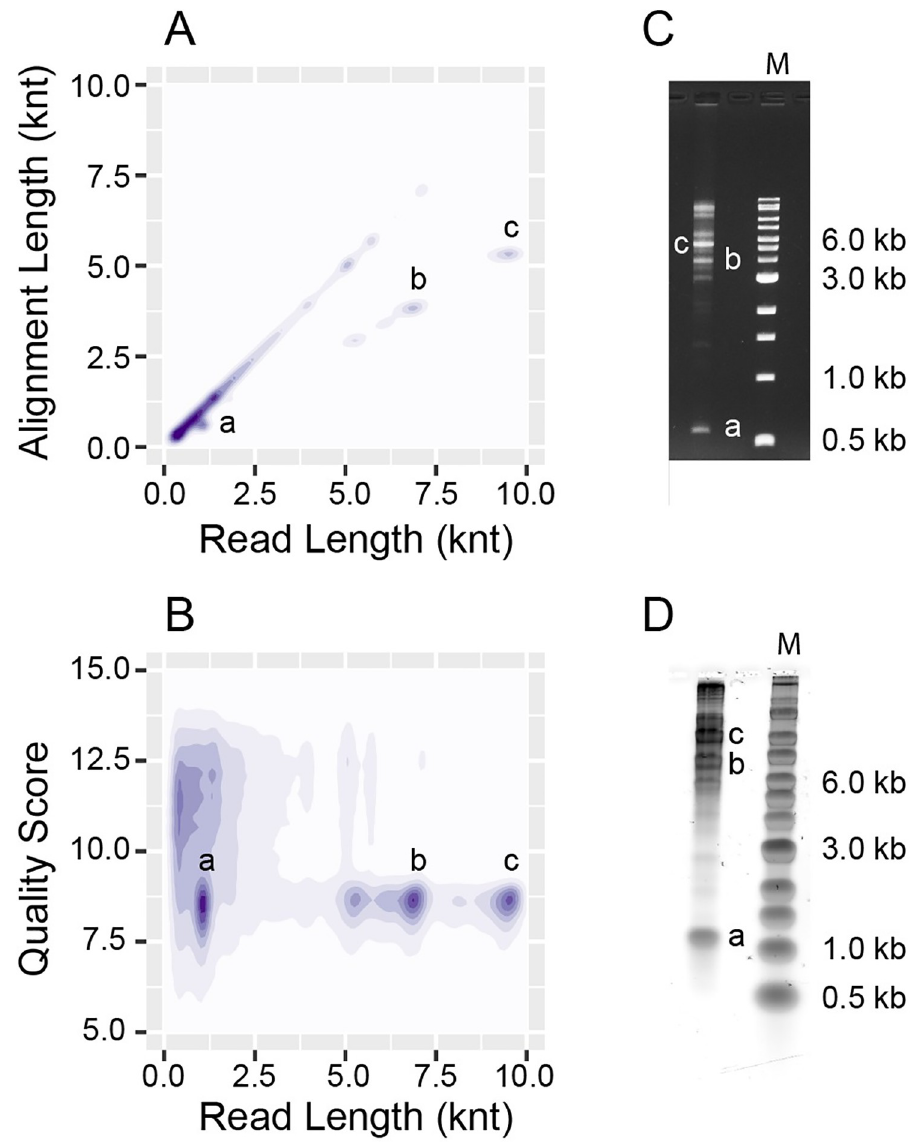
Fig 4. Amplification of hairpins in a T7 SDA reaction. Data are shown for the reaction of WT gp5 and Nt.BssSI. ( A ) Kernel density estimate (KDE) plot of read length against alignment length. Only one alignment is considered per read. ( B ) KDE plot of read length against average read quality score. ( C ) Non-denaturing agarose gel of the reaction products stained with ethidium bromide. ( D ) Denaturing alkaline agarose gel of the reaction products. In each panel, clusters of amplified hairpin DNA molecules are labeled with lower case